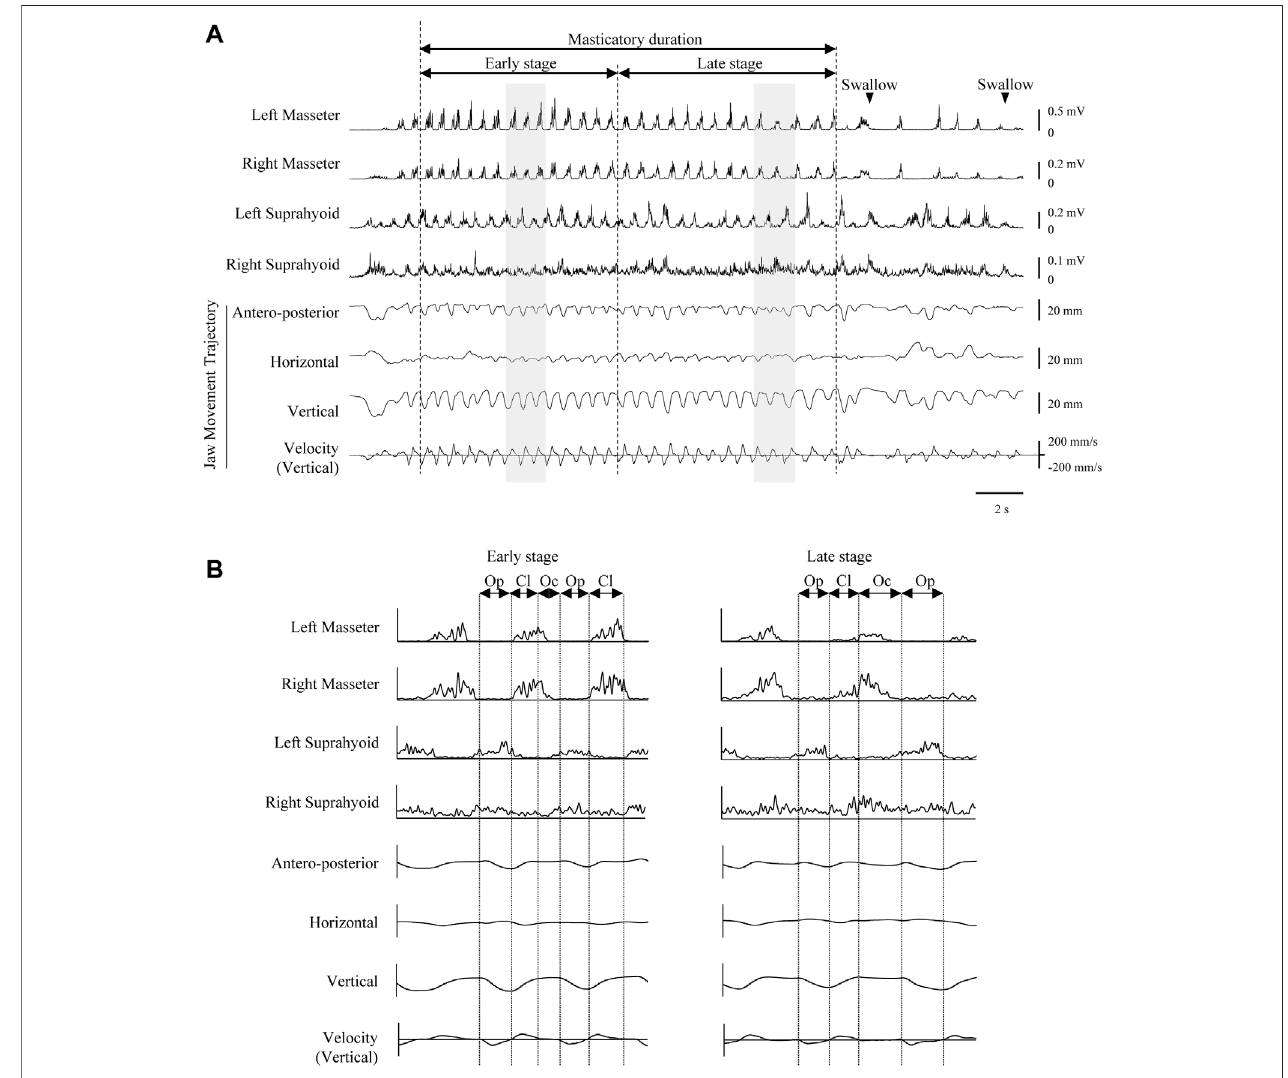
FIGURE 3 | Representative electromyographic (EMG) activity recording and mandibular movement trajectories during Happy mastication on the habitual (right) side. Recti fi ed and smoothed EMG waveforms are shown. (A) Vertical dotted lines indicate masticatory onset, border between early and late stages, and offset of masticatory duration. (B) Expanded view of shaded areas in recordings A. Reciprocal EMG bursts commonly observed in masseter and suprahyoid muscles on both sides in the early stage. Vertical dotted lines indicate the border between phases. Cl, jaw-closing phase; Oc, occlusal phase; Op, jaw-opening phase.